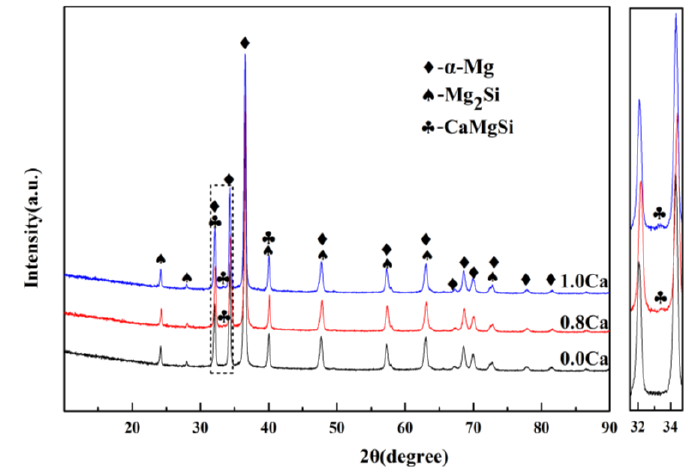
Figure 7. The XRD pattern of Mg–4Si–yCa (y = 0 wt.%, 0.8 wt.%, 1.0